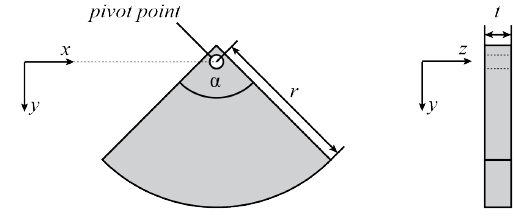
Figure 7. Geometry and orientation of the rotational mass. Figure 5. Initial state of the battery charging circuit.